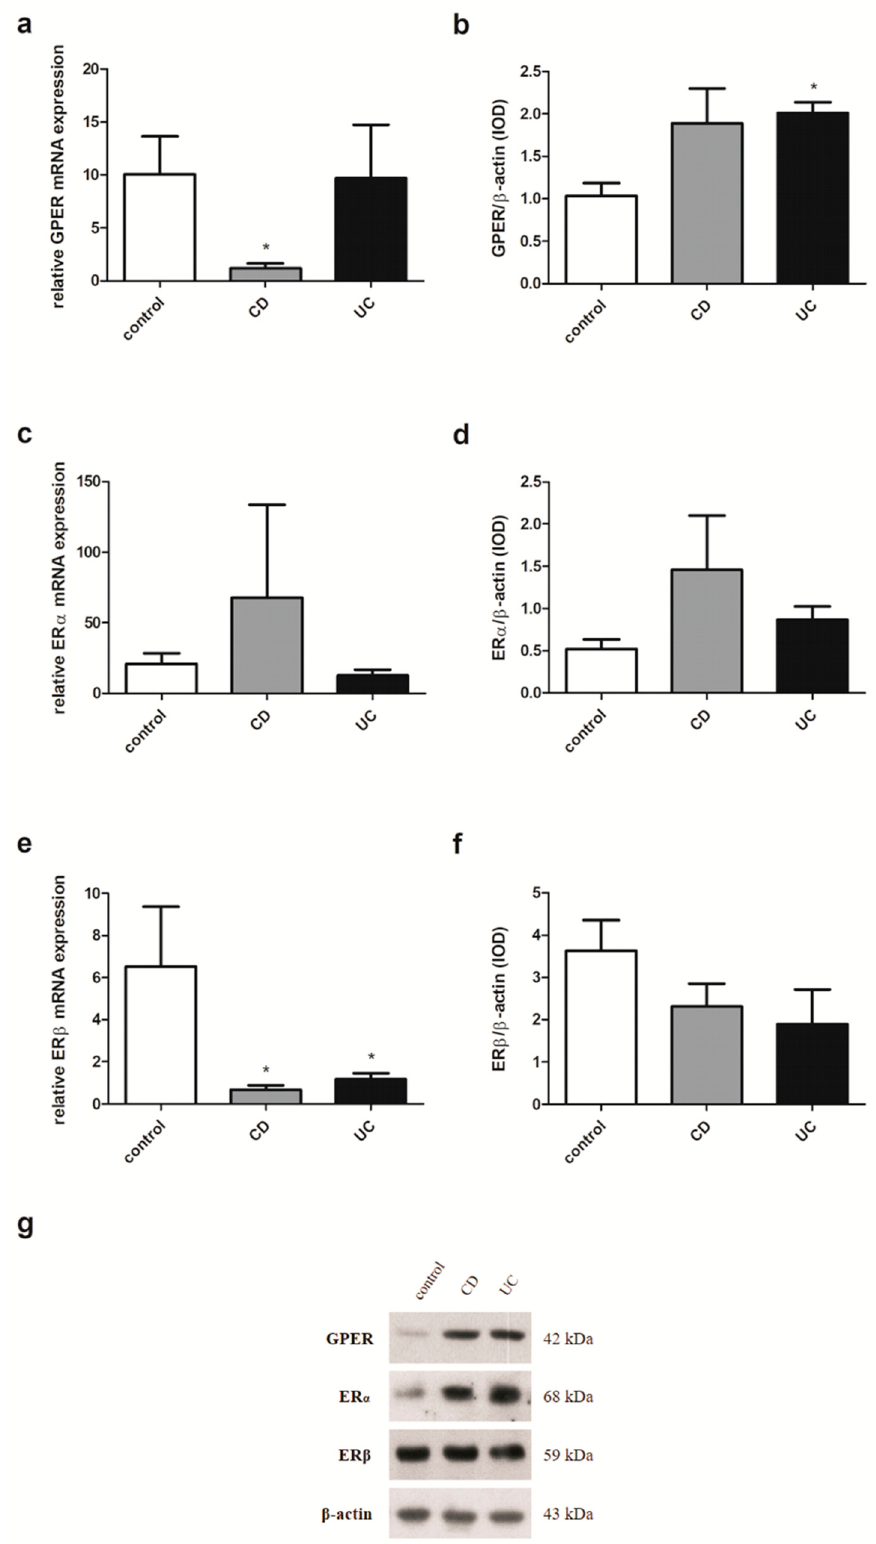
Figure 5. Expression of GPER ( a , b ), ER α ( c , d ) and ER β ( e , f ) at the mRNA ( a , c , e ) and protein level ( b , d , f ) in females with CD and UC under the age of 50 years and related controls (control, n = 9; CD, n = 7; UC, n = 12). Representative immunoblots of GPER, ER α and ER β ( g ). Values are means ± SEM; * P < 0.05 vs. control.